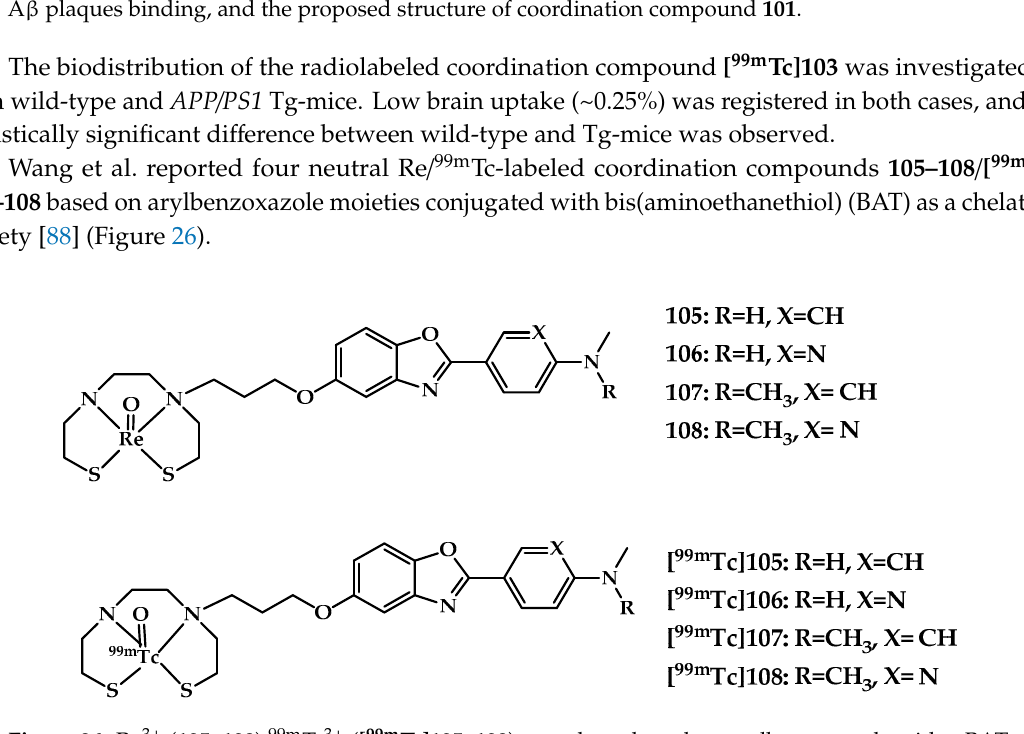
Figure 26. Re 3 + ( 105 – 108 ) 99m Tc 3 + ([ 99m Tc]105–108 ) complexes based on arylbenzoxazole with a BAT metal-chelating moiety, designed for SPECT imaging of A β